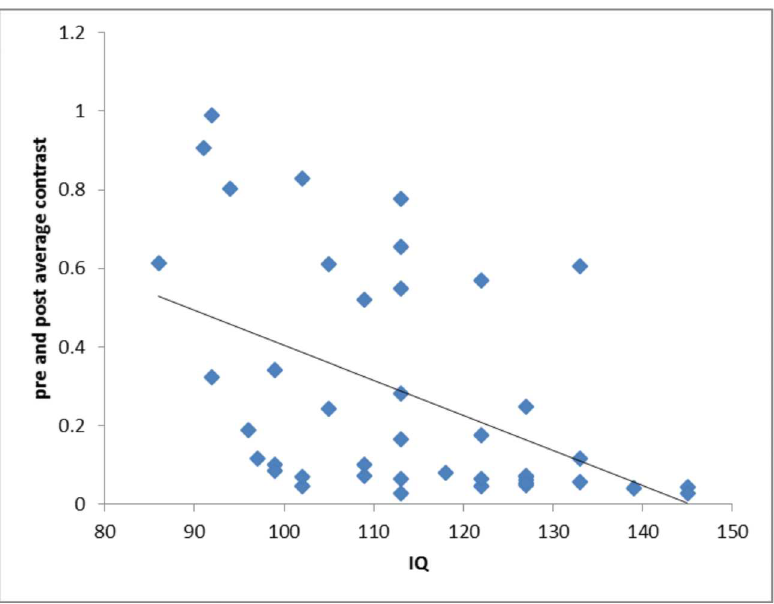
Fig 5. Relationship between IQ and averagecontrast. The relationshipbetweenCattell CultureFair IQ score and averagecontrast. Each blue diamondrepresents a single participant’s averagescore for both experimental blocks. The black line is a linear best fit of the data. There was a significantnegativerelationship betweenIQ and contrast, such that higherIQ participants tended to achieve a more difficult contrast